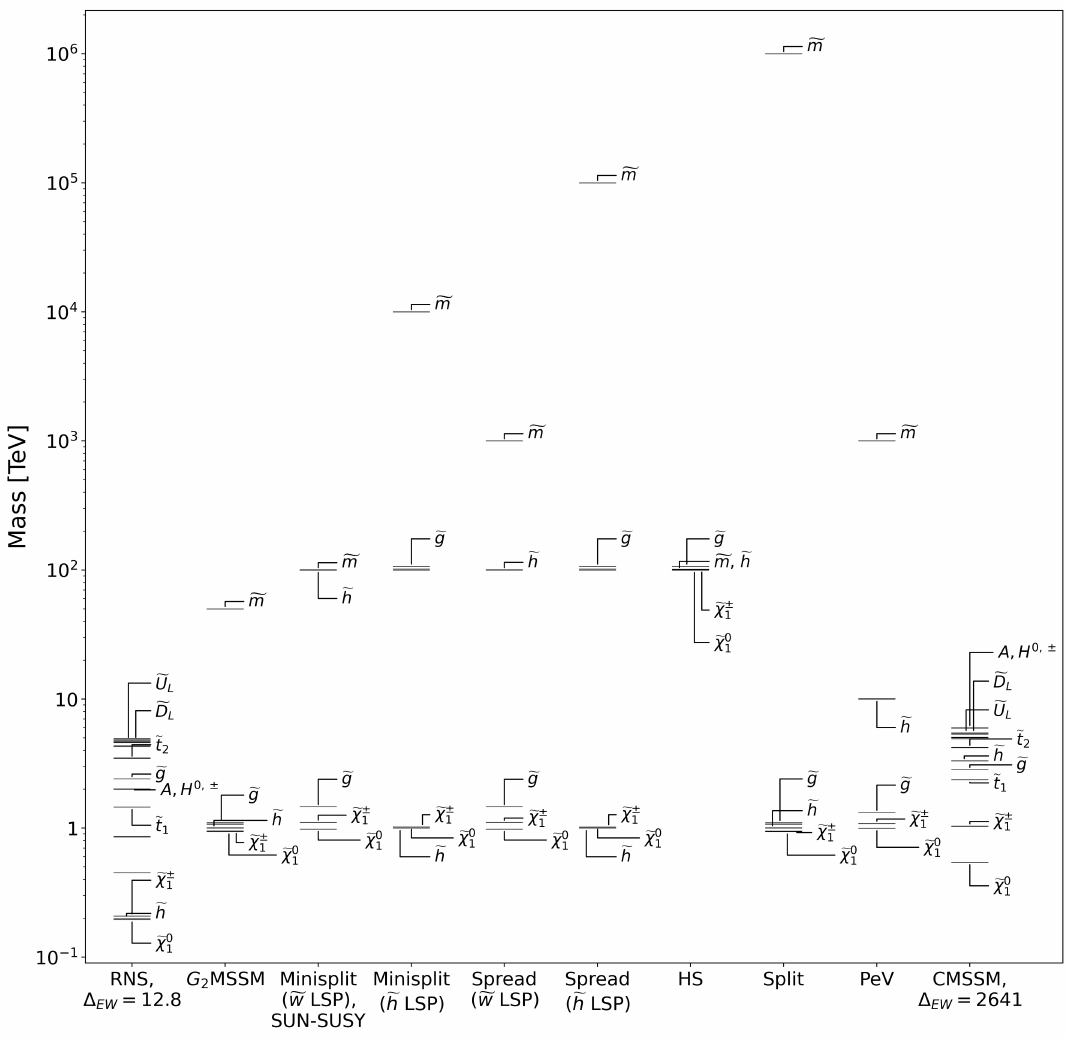
Figure 1 . Mass spectra from various unnatural and natural SUSY models as depicted in table